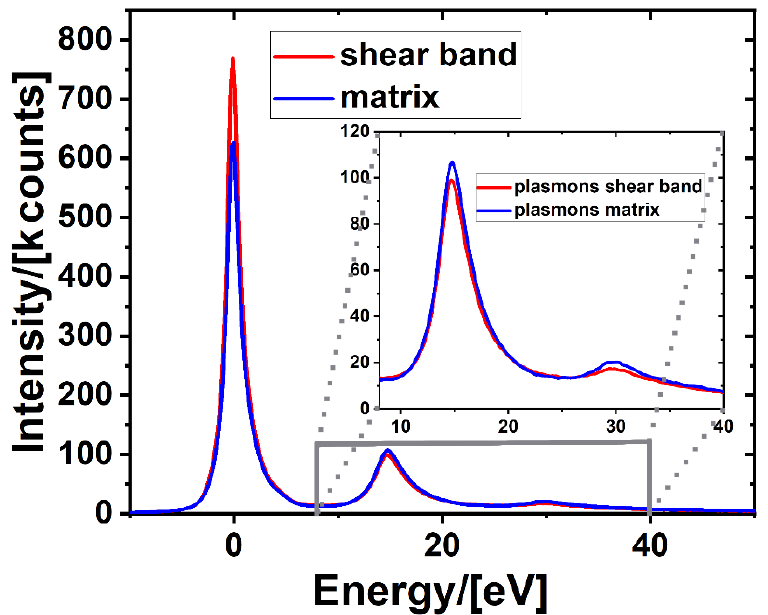
Figure 3. Representative EEL spectra taken from the matrix (blue) and the shear band (red) corresponding to the shorter line scan in Figure 1b, showing zero loss and plasmon peaks. The low-loss part (0–50 eV) was used for the thickness calculations. The inset shows an enlarged view of the plasmons. Note the difference in peak heights between the matrix and shear band.